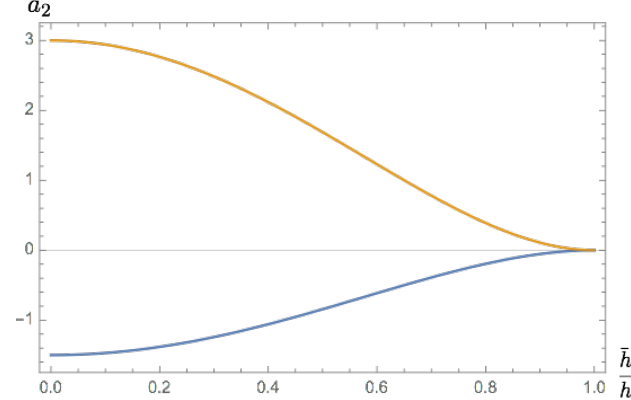
Figure 1 . The bounds on the coe(cid:14)cient a 2 of h J (cid:22) J (cid:23) T (cid:26)(cid:27) i derived from the negativity of the anomalous dimensions in the Regge limit (cid:13) ( T )